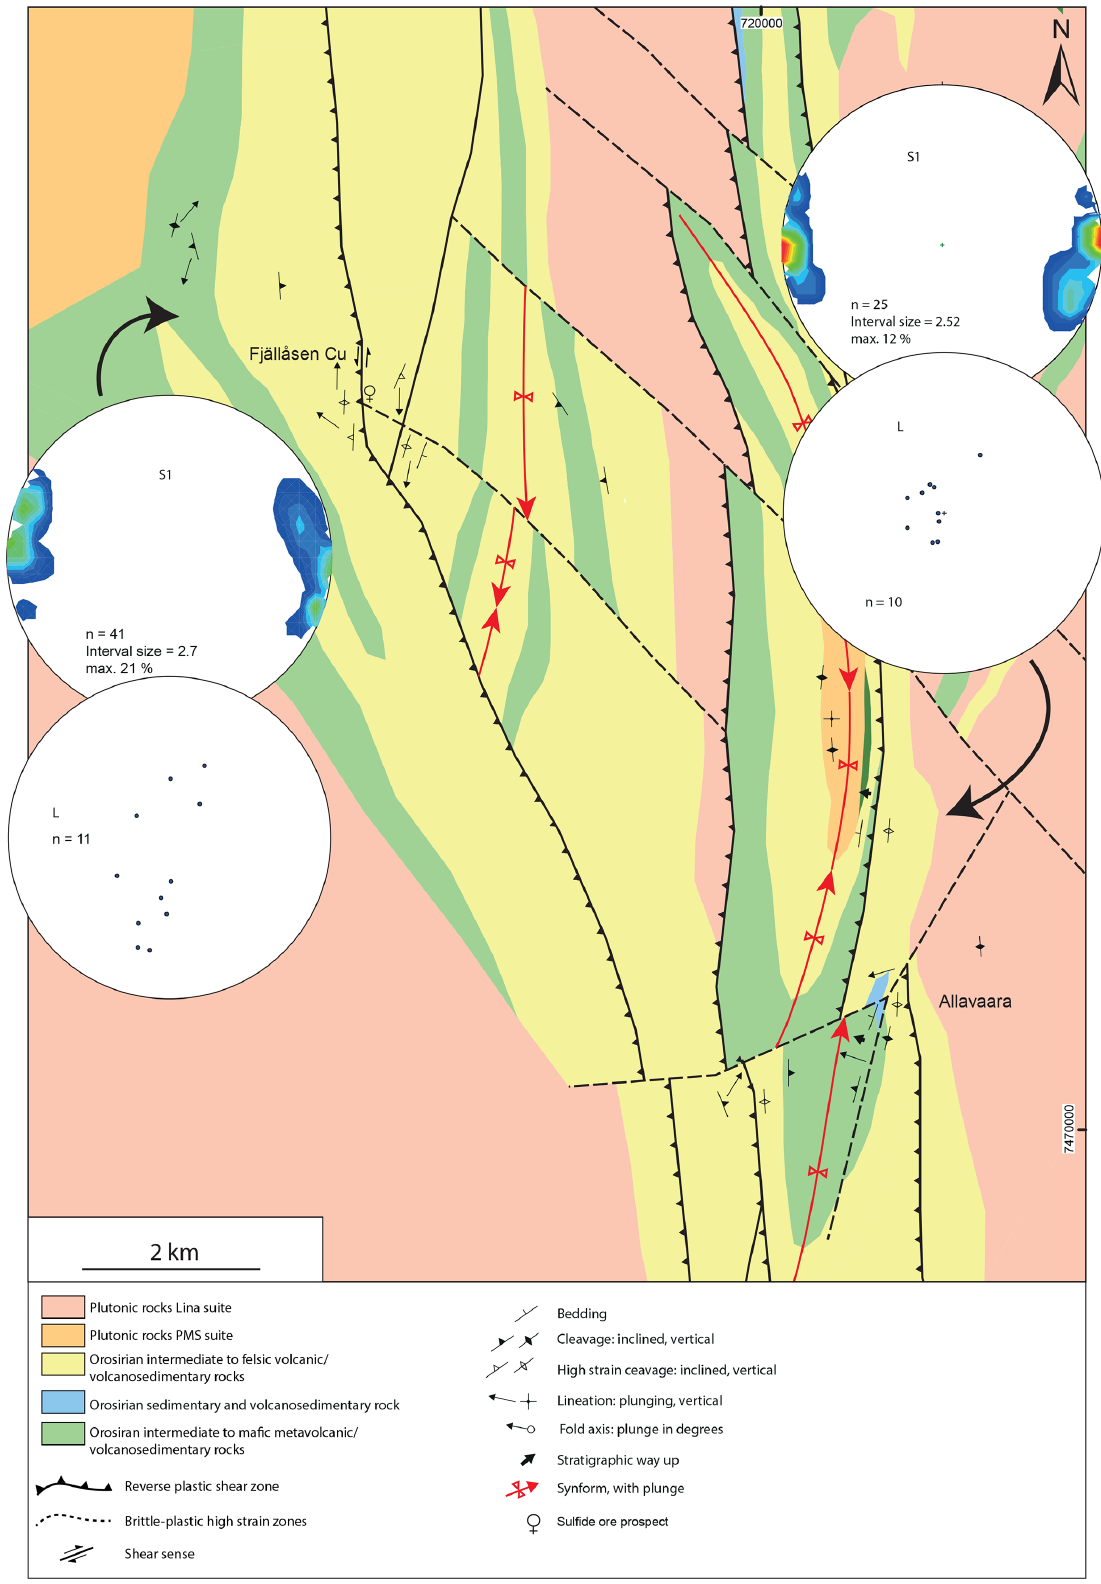
Figure 14. Geological map of the Fjällåsen–Allavaara key area. Modified after Witschard (1975). Coordinates: Sweref99.